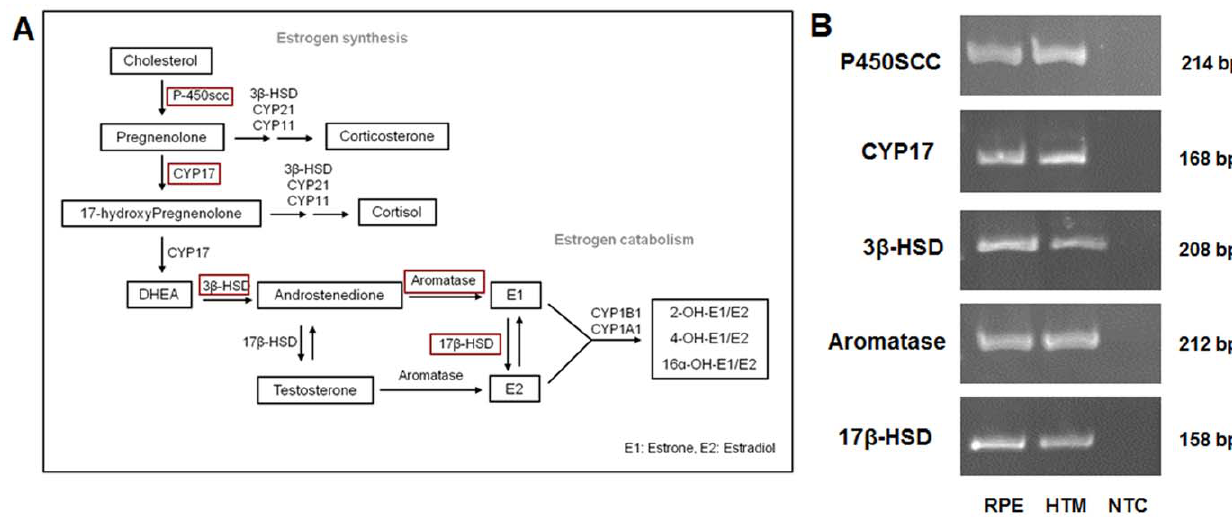
Figure 2. Expression of 17 b estradiol synthesizing enzymes in HTM and RPE cells. A : 17 b estradiol synthesis pathway. The key enzymes are highlighted by red squares. B : Semi-quantitative RT-PCR showing the presence of key 17 b estradiol synthesizing enzymes in HTM and RPE cells. Three independent experiments were done for each enzyme in both cell lines. The identity of each product was confirmed by sequencing (data not shown). NTC: No cDNA template control.